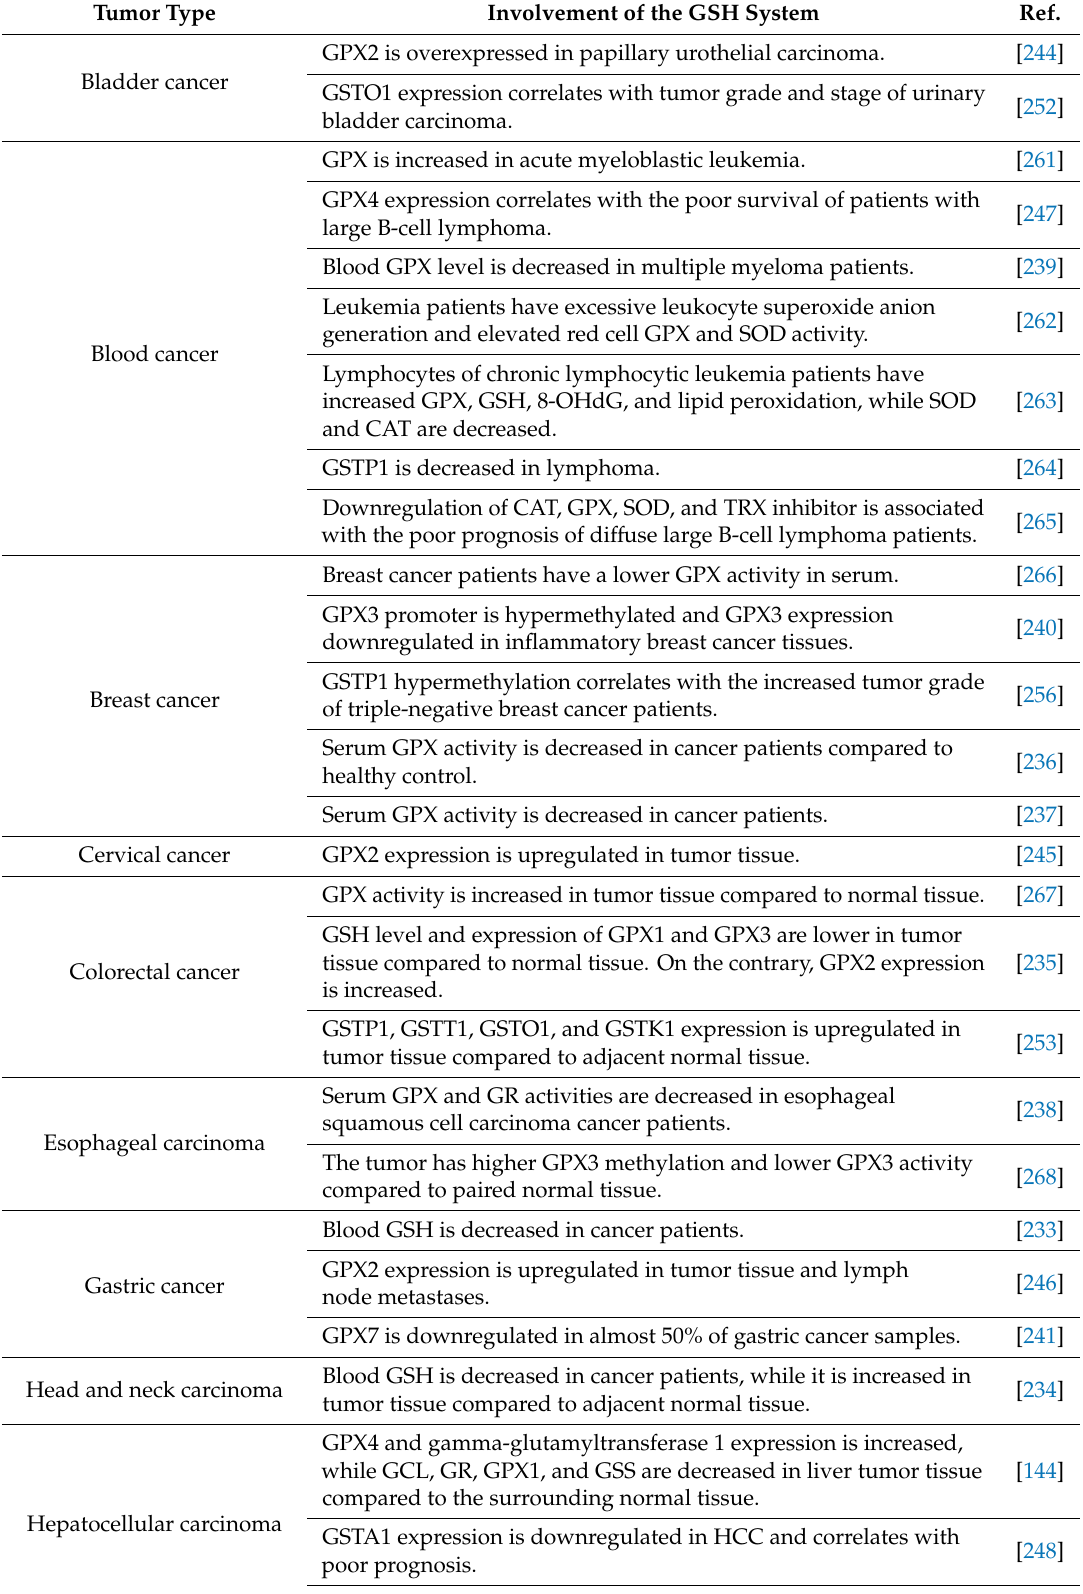
Table 4. The implication of the GSH system in